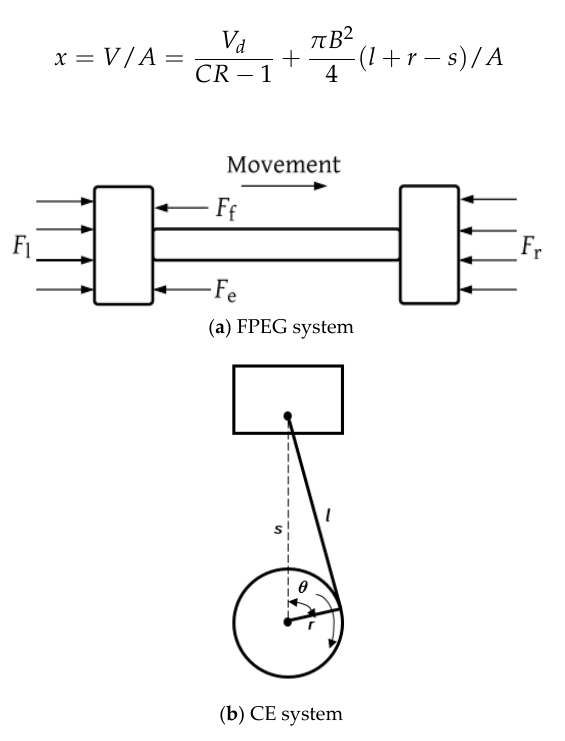
Figure 2. Schematic figures of an FPEG and a conventional engine (CE).